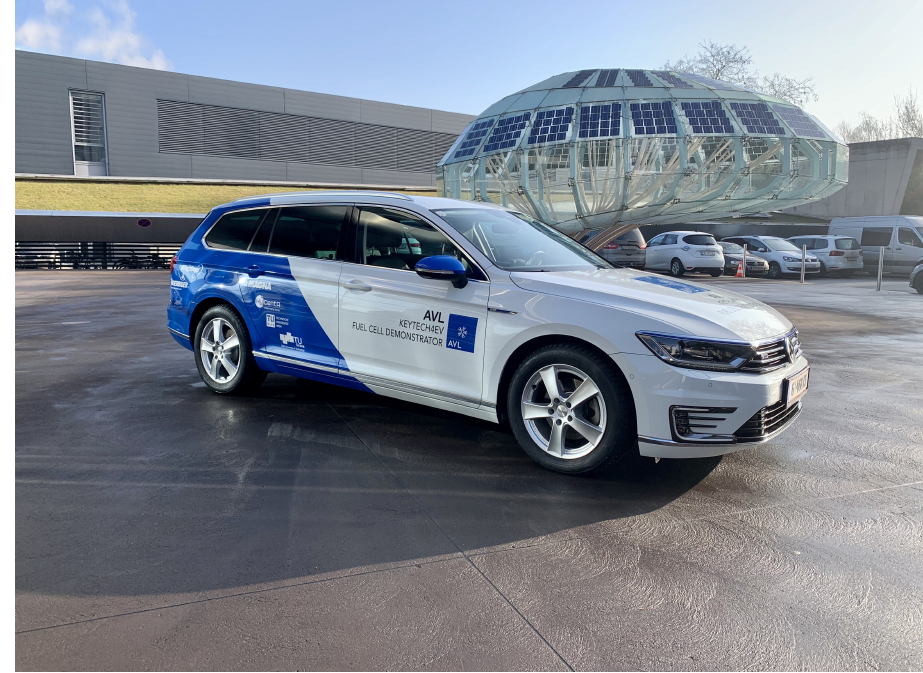
Figure 2. AVL List GmbH research demonstrator vehicle.